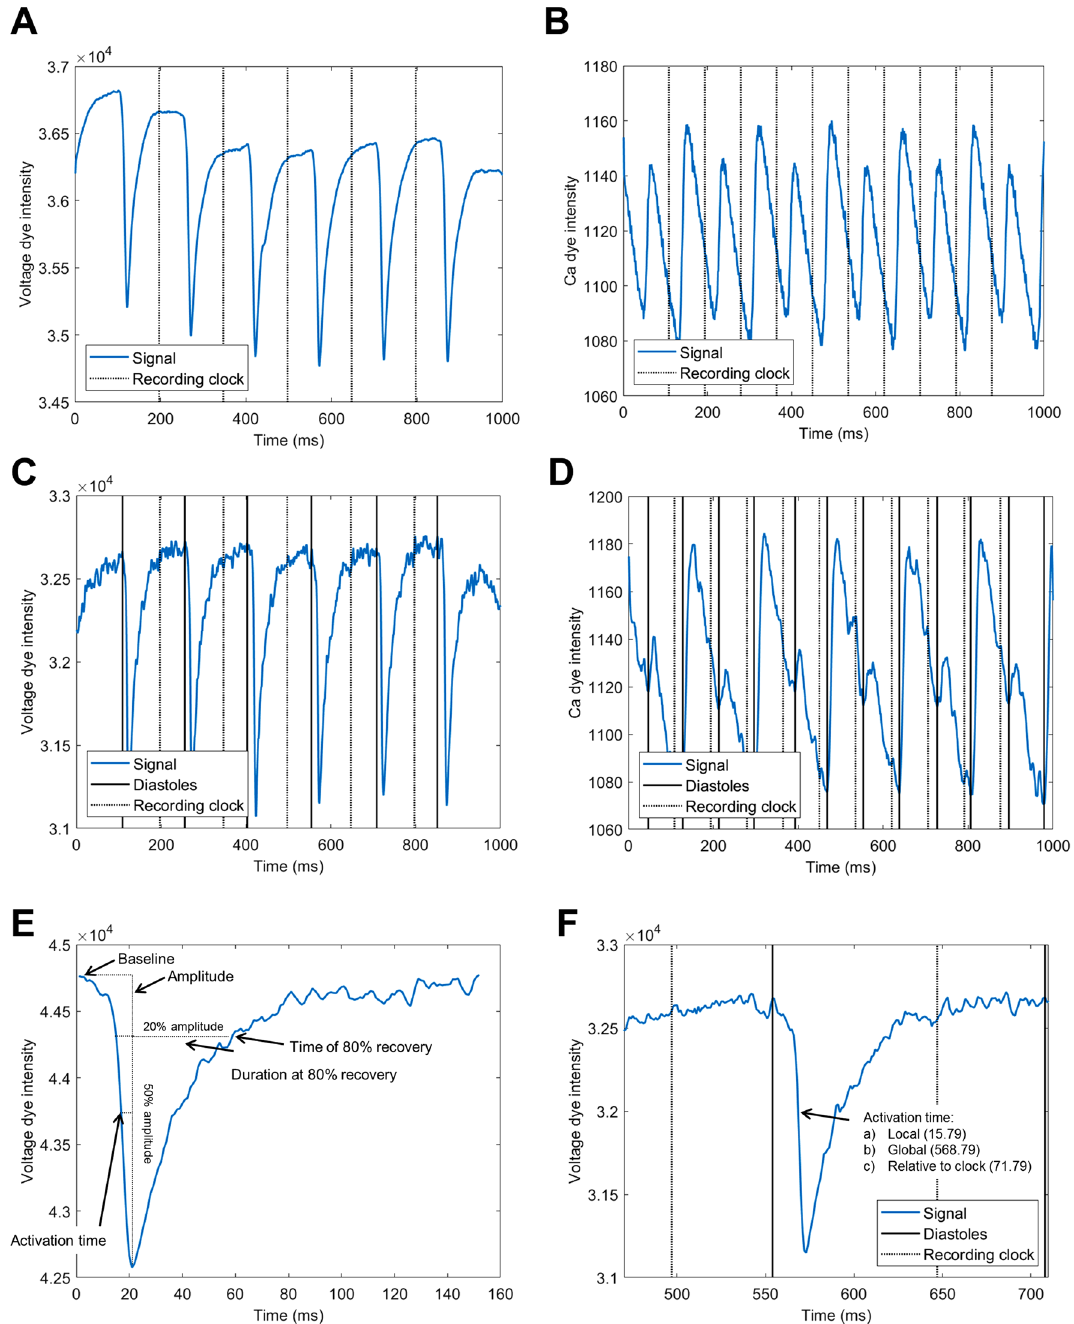
Figure 3. Illustration of stimulus segmentation and feature extraction. ( A ) Average trace of a voltage mapping recording in rat heart at 130 ms basic cycle length (the lower the intensity, the higher the membrane potential), showing the recording clock (half-points between peak activations). ( B ) Average trace of a calcium mapping recording in rat heart at 85 ms basic cycle length (the higher the intensity, the higher the calcium concentration), showing amplitude alternans. ( C ) Single-pixel trace from the recording used in ( A ), also showing the points corresponding to the points of smallest activation (“diastoles”, solid black lines), as well as the global clock (dotted black lines). ( D ) Single-pixel trace from the recording in ( B ), showing pronounced calcium alternans. This recording illustrates, among other things, that despite baseline subtraction and signal smoothing, no single threshold can be used to satisfactorily segment distinct CaTs, while the comb-based approach of COSMAS correctly identifies CaTs as the intervals between diastoles. ( E ) Illustrations of features extracted on a single rat AP. ( F ) Illustration of how activation times are treated. Within single activation, the local activation time is first extracted (15.79 ms after the preceding diastole). This corresponds to the global time (within the whole recording) of 568.79 ms, from which the time of the preceding clock boundary is subtracted, and COSMAS records that the activation came 71.79 ms after the preceding clock. In this way, even though each pixel’s trace may have diastoles detected at different times, all pixels are synchronized to the same global clock, which allows extraction of meaningful activation maps for each pass of a cardiac